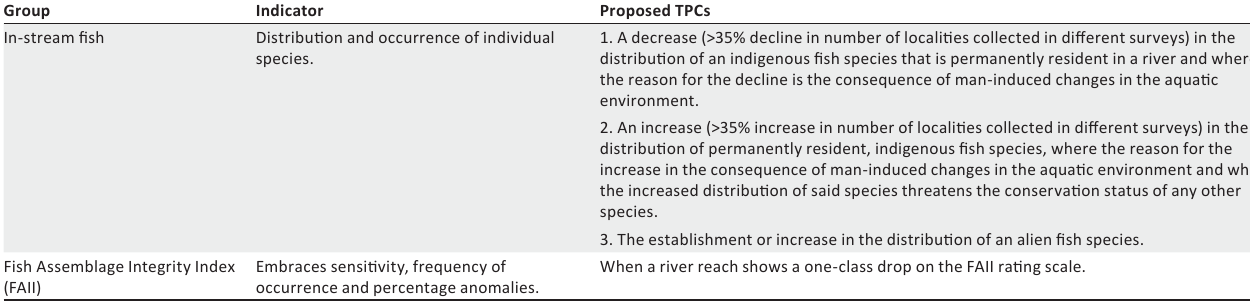
TABLE 4: The developed and more focused fish thresholds of potential concern (TPCs) for the Kruger National Park rivers. Group Indicator In-stream